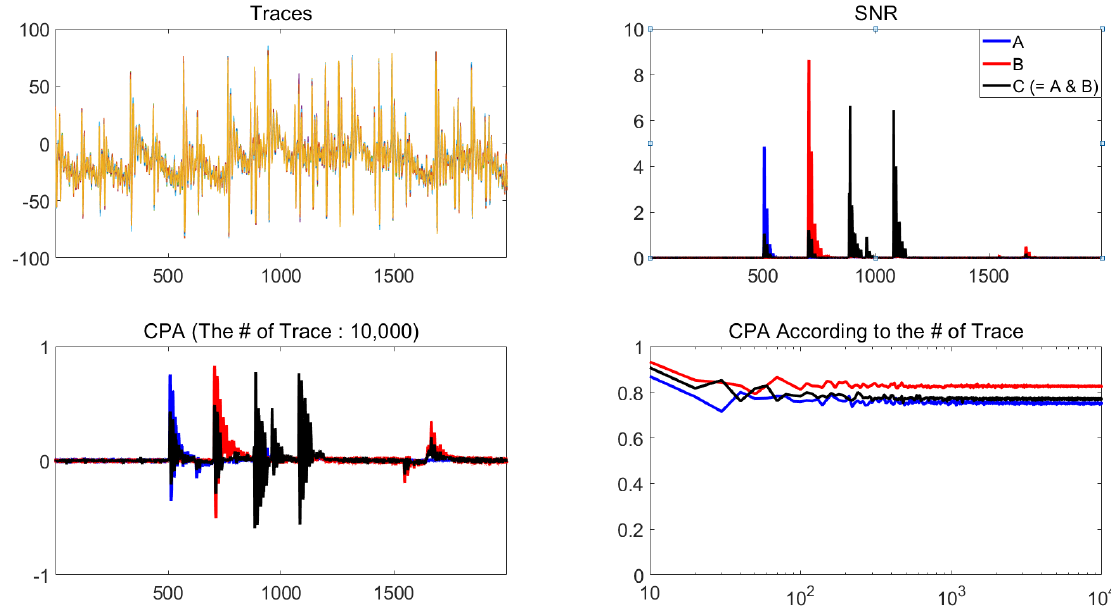
Figure 1. Evaluation Results of the